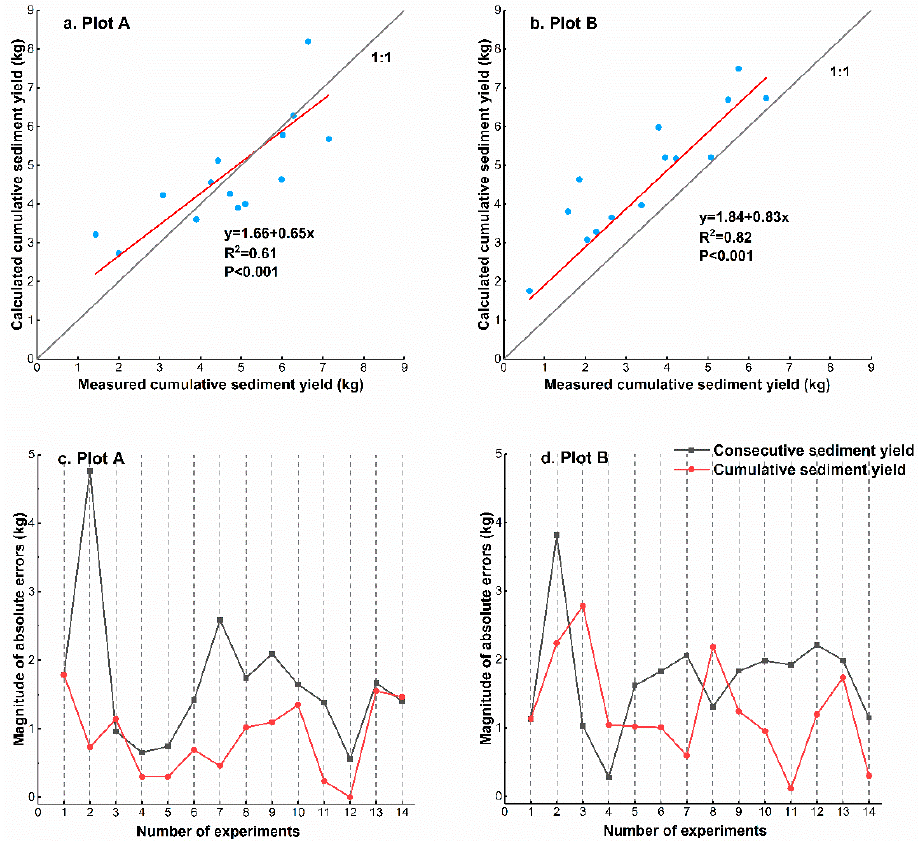
Figure 4. Linear regressions of the measured and TLS-derived cumulative hillslope sediment yield calculated at the 5-mm grid-cell size for plot A ( a ) and plot B ( b ), and the magnitude of absolute errors of the TLS-derived consecutive and cumulative hillslope sediment yields calculated at the 5-mm grid-cell size for the 14 experiments with plot A ( c ) and plot B ( d ).